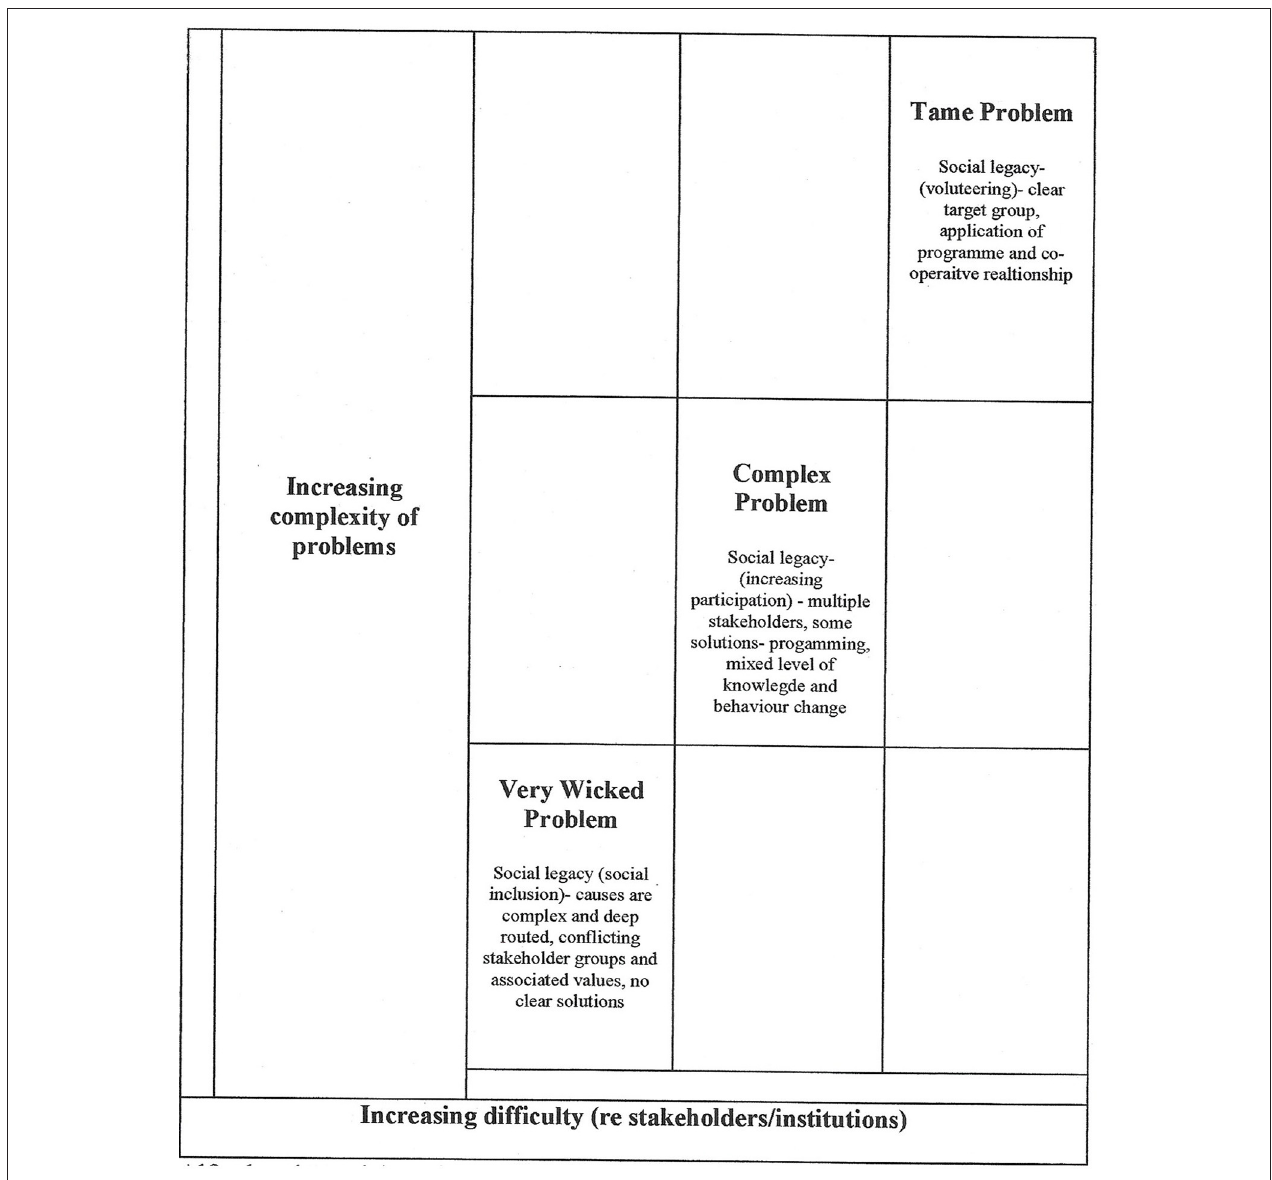
FIGURE 2 | Complexity of wickedness: An illustration. Adapted from Alford and Head (2017) applied to the Paris 2024 social legacy plans.